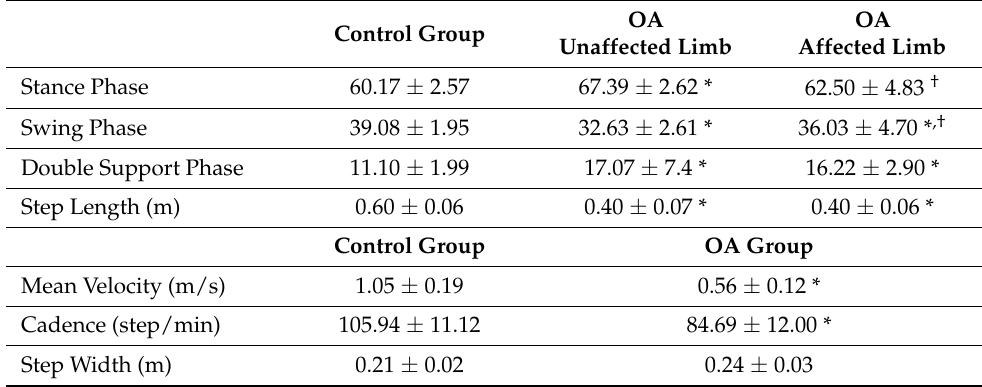
Table 2. Spatio-temporal parameters of gait. Stance, swing, and double support phases are expressed as percentage of the gait cycle duration. Values are expressed as mean ±